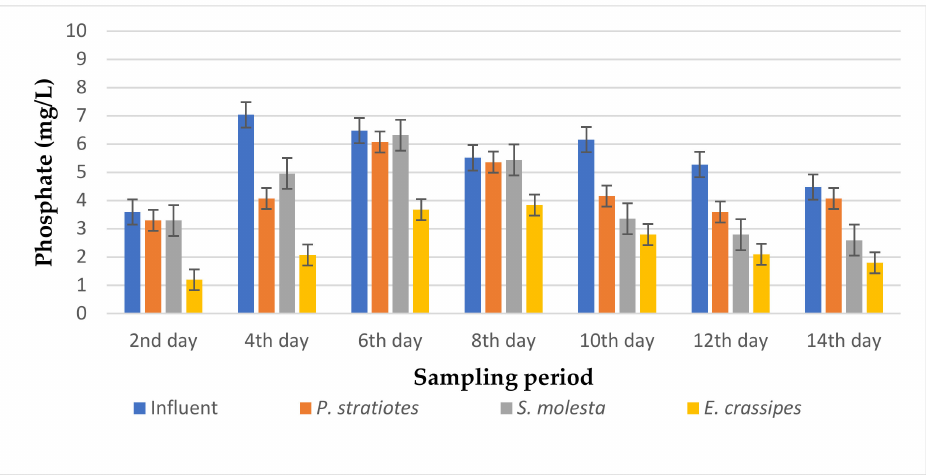
Figure 7. Bar plot of the average phosphate vs. the sampling period with a 12 h retention